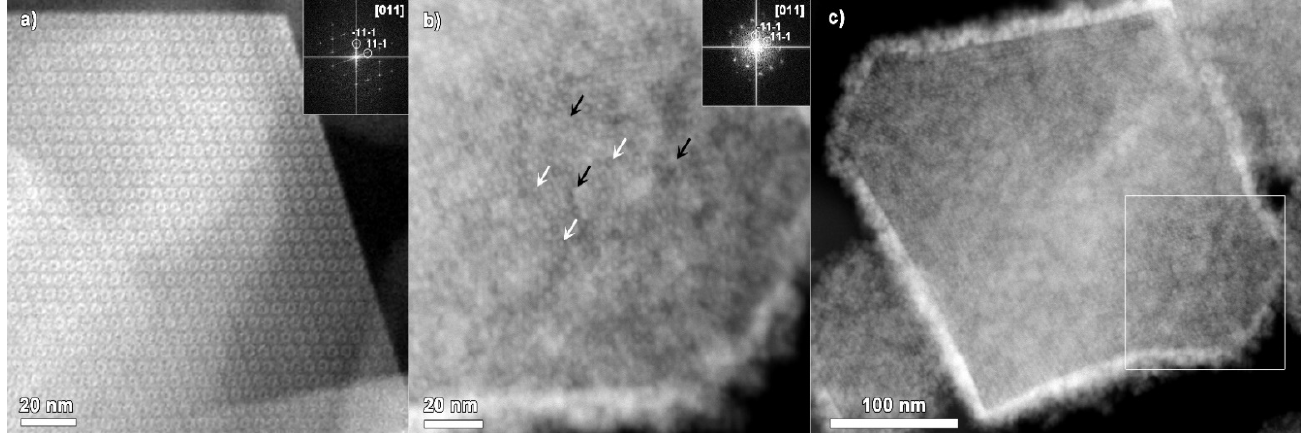
Figure 2. ( a ) ADF-STEM image of MIL-101 crystal taken along the [011] zone axis (Fourier transform pattern is placed in the inset) and ( b ) ADF-STEM image of the Ru@MIL crystal taken along the [011] zone axis of MIL-101 together with the corresponding Fourier transform pattern. The arrows are pointing to some examples of Ru nanoparticles in the smaller (white arrows) and bigger (black arrows) cages of MIL-101. ( c ) ADF-STEM overview of MIL-101 crystal heavily loaded with Ru nanoparticles.